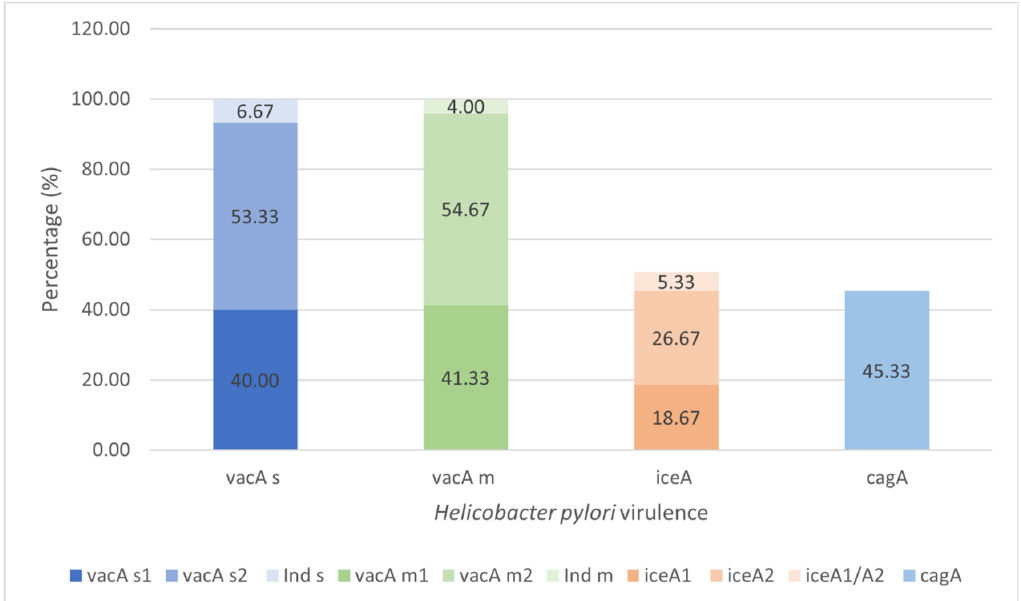
Figure 4. Prevalence of the virulence VacA, CagA, and IceA of the colonizing H. pylori strains in gastric tissue ( n = 75 ). Bacterial DNA amplification for the vacA , cagA and iceA by the PCR (Polymerase Chain Reaction) test and PCR-RFLP (Restriction Fragments Length Polymorphism) assay to confirm the s and m alleles of vacA , visualized in gel of agarose 1.5% (Cleaver Scientific, Rugby, UK). Ind s or Ind m , refer to alleles s or m of Vac non-specified by PCR or PCR-RFLP methods. Values represent a percentage of the totals. 3.5. Expression Levels of GRN mRNA in the Gastric Tissue, According to the Virulence Characteristics of H. pylori Strains The gene expression of PGRN showed no changes according to the virulence of H. pylori (Figure 5).